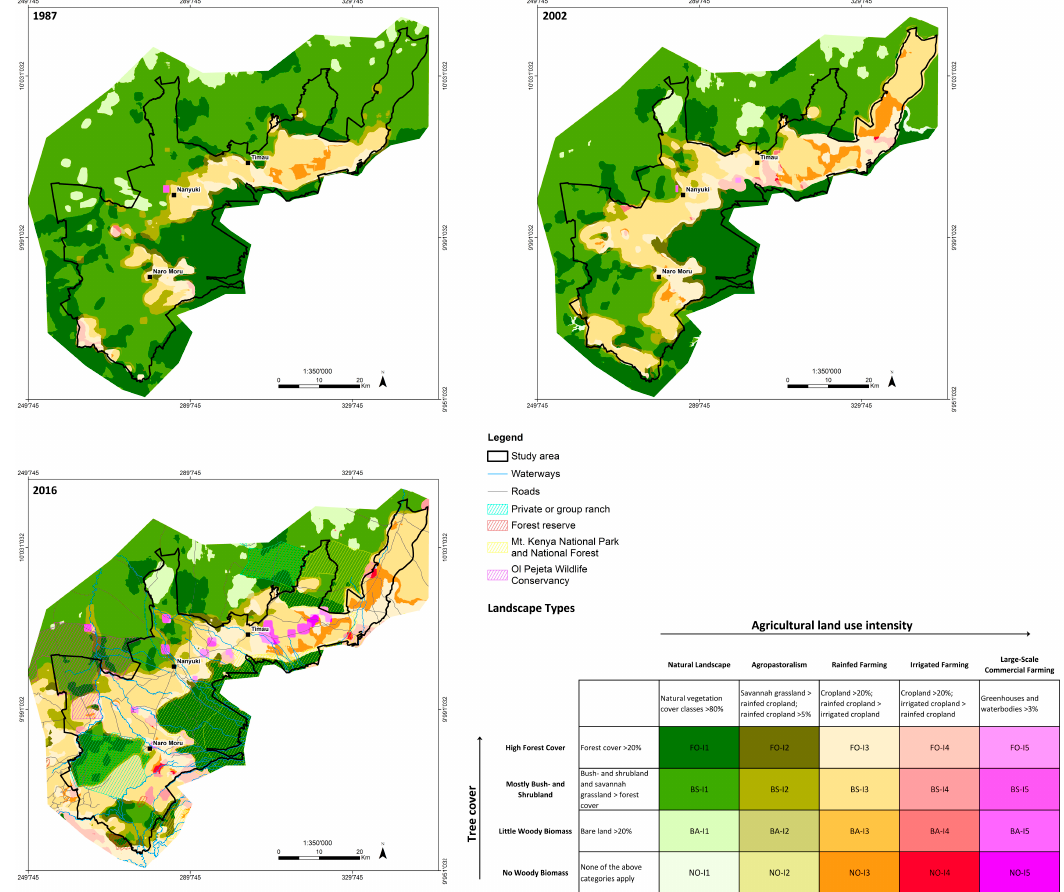
Figure 5. Landscape mosaic maps for 1987, 2002, and 2016, overlaid with waterways (map projection: UTM 37S). The map for 2016 additionally shows different types of protected or managed areas and the road network. Land use intensity increases with the color gradient changing from dark green towards dark pink. The darker and more intense the green and olive colors, the more woody biomass there is. The more intense the orange, red, and pink colors, the less woody biomass there is and the more intensively the land is used.